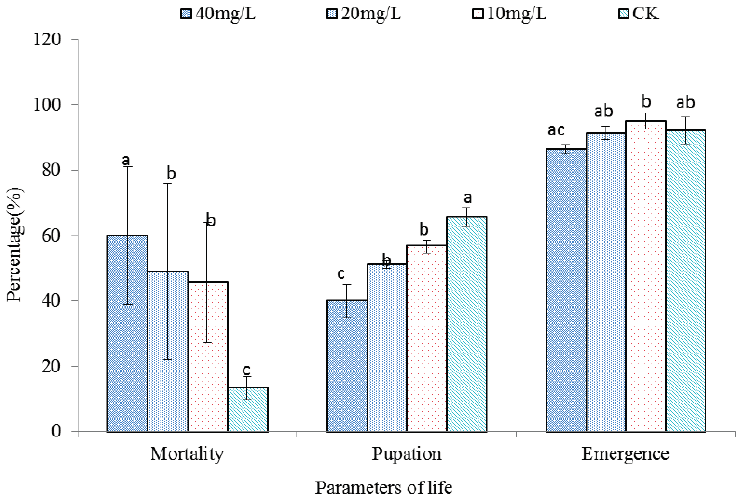
Figure 2. Effect of total alkaloids on mortality, pupation and emergence of Spodoptera litura . Bar (±SE) followed by the same letter within a parameter are not significantly different at p < 0.05 based on Duncan’s multiple range tests for pupation, emergence, and mortality. CK: 70% ethanol